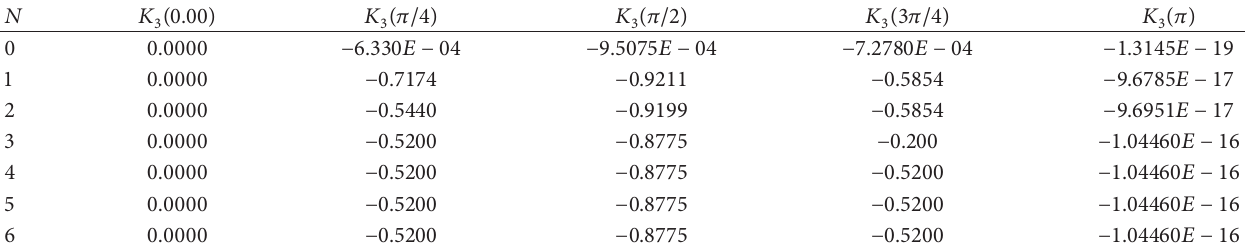
Table 3: Numerical convergence for the tearing mode stress intensity factor, 𝐾 3 (𝜙) , for 𝑚 = −2 when 𝑐 = 0.1